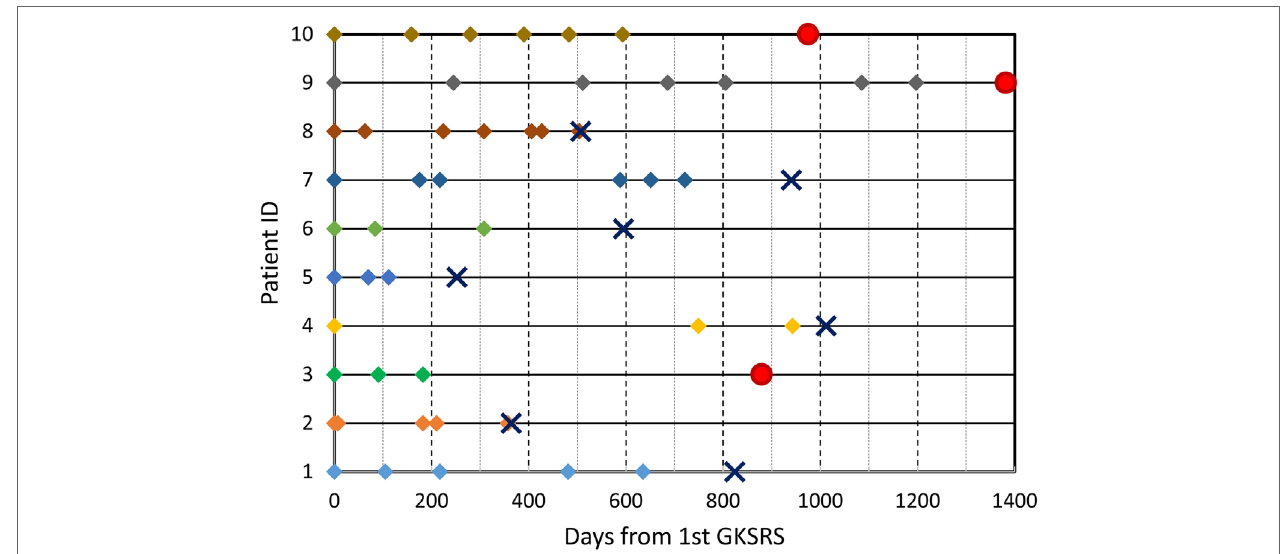
FigUre 2 | GKSRS treatment timeline and vital status of ten patients. The diamond symbols indicate the time of treatment visit in days since the first GKSRS. The circle indicates last follow up for alive patients, and the cross “X” indicates the time of